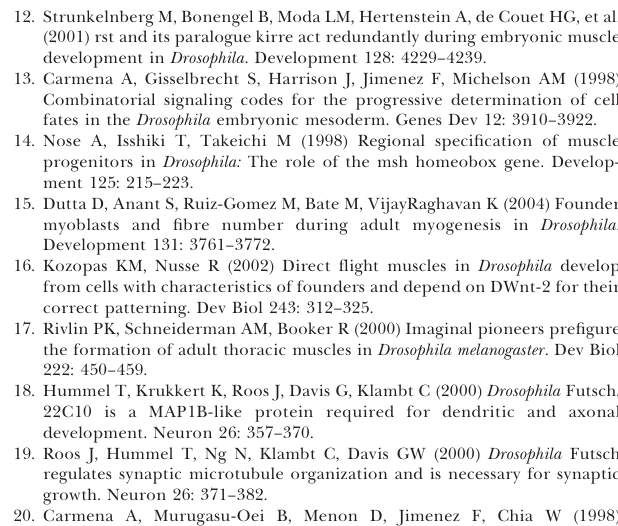
Figure S2. Founder Number and Myoblast Number upon Modifica- tion of Htl Levels Using the tub-GAL80ts System Fluorescent images of pupae stained with antibodies 22C10 (red),